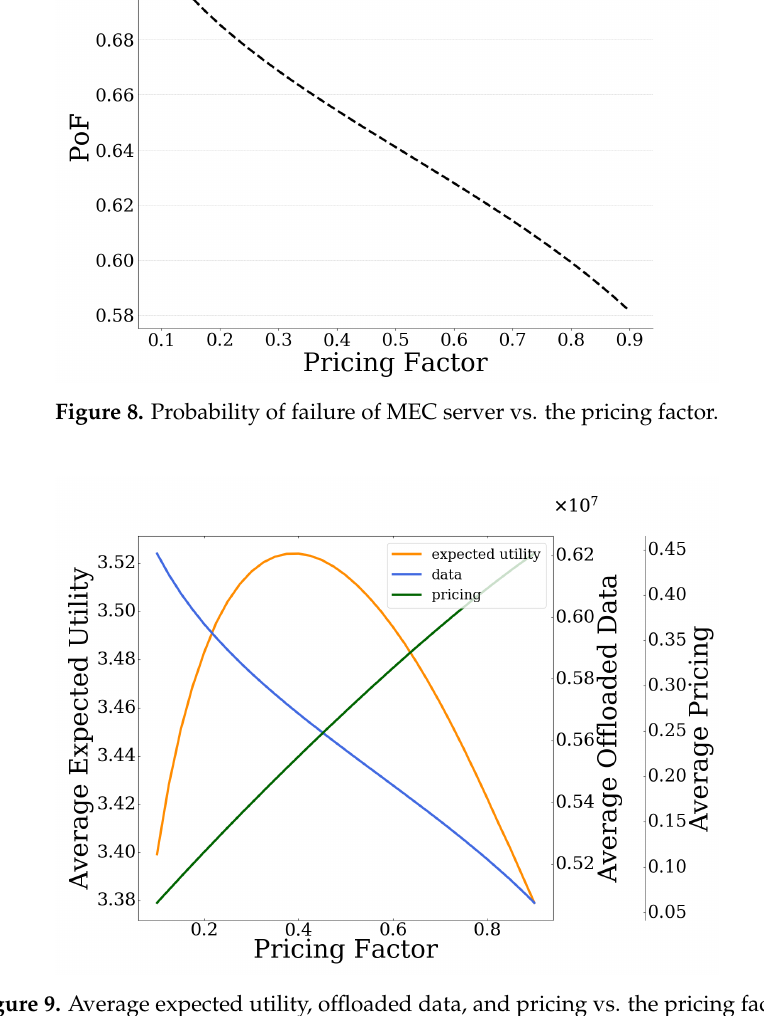
Figure 9. Average expected utility, offloaded data, and pricing vs. the pricing